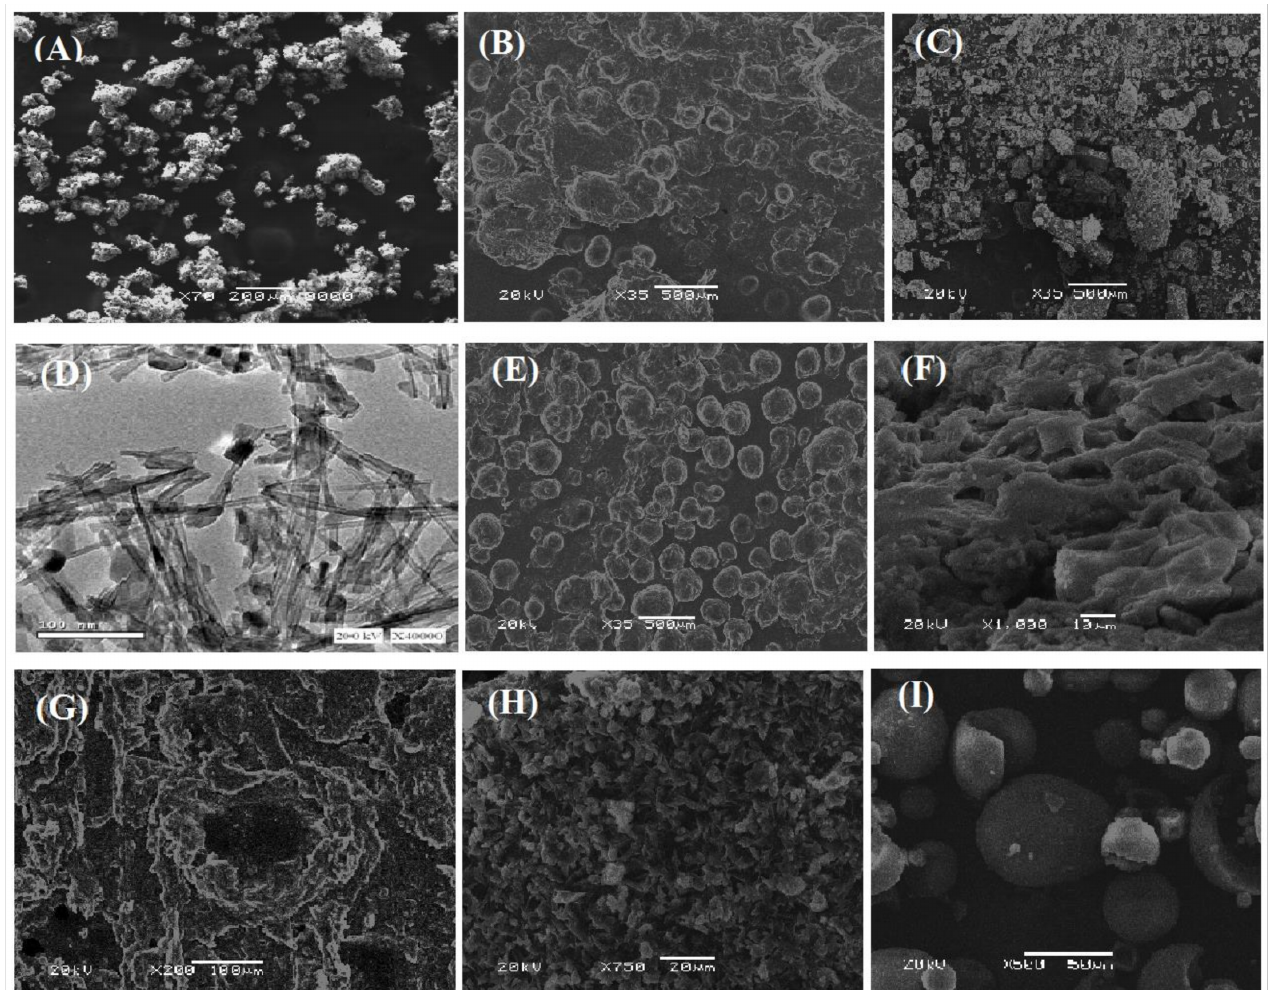
Figure 6. SEM images of the sulfa drug and prepared antimicrobial agents based on PEG. ( A ) α -CD, ( B ) PEG/ α -CD, ( C ) PEG/ α -CD/Drug, ( D ) TiO 2 NPs, ( E ) PEG/TiO 2 , ( F ) PEG/TiO 2 /Drug, ( G ) PEG/ α -CD/TiO 2 , ( H ) PEG/ α -CD/TiO 2 /Drug, ( I )